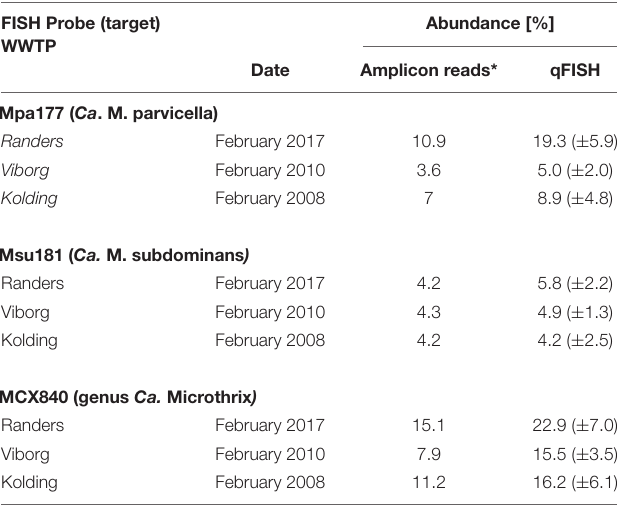
TABLE 2 | Ca. Microthrix abundance estimation using amplicon sequencing and